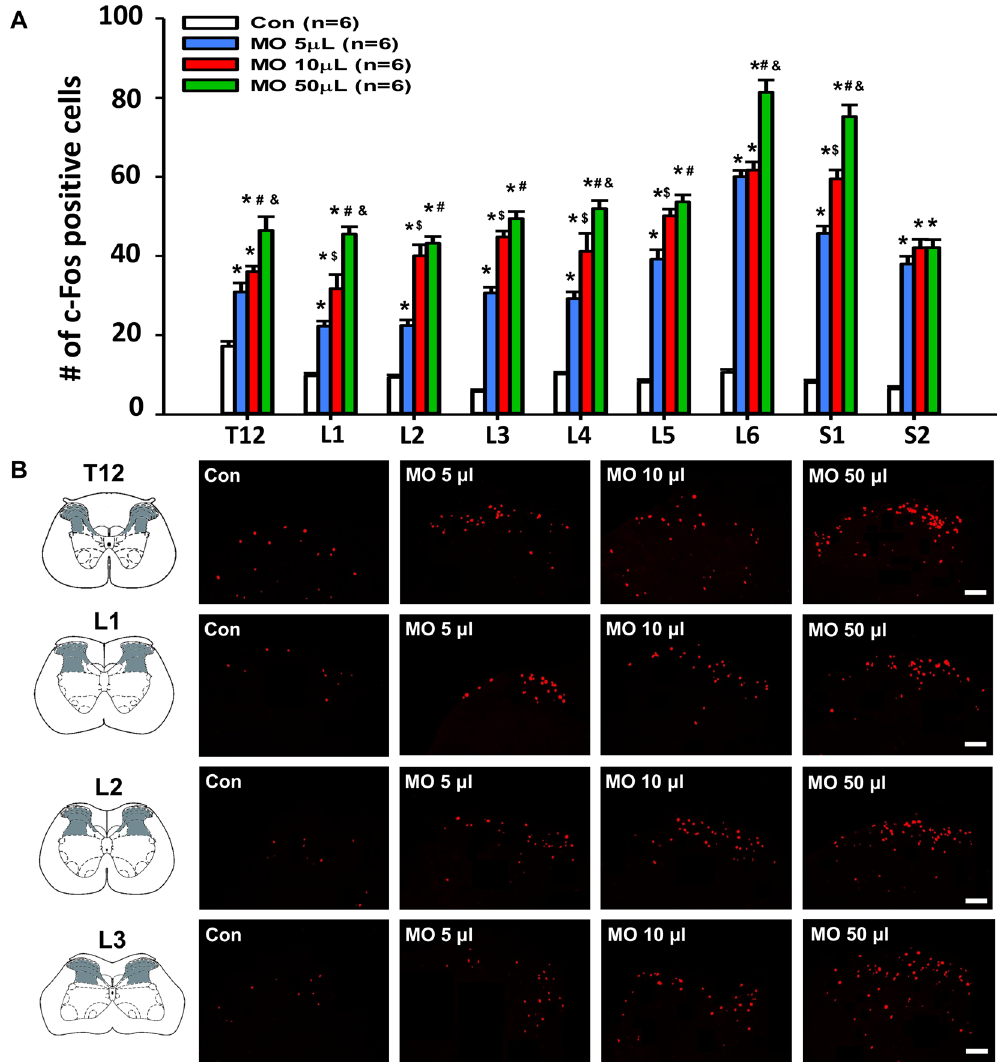
Figure 4. Increased c-Fos expression in the spinal dorsal horn following MO-induced colonic pain. (A ) Quantification of c-Fos labeled neurons in the T12-S2 in MO-infused rats (n = 6/group). Data are expressed as the numbers of c-Fos-positive cells in the T12-S2 per mm 2 . * p < 0.05, MO 5 μ l vs. Con (control); $ p < 0.05, MO 5 μ l vs. MO 10 μ l; # p < 0.05, MO 5 μ l vs. MO 50 μ l; & p < 0.05, MO 50 μ l vs. MO 10 μ l. ( B ) Representative images of c-Fos expression in the T12-L3 of the spine following Con (control; mineral oil) or MO 5, 10 or 50 μ l application. Bar = 50 μ